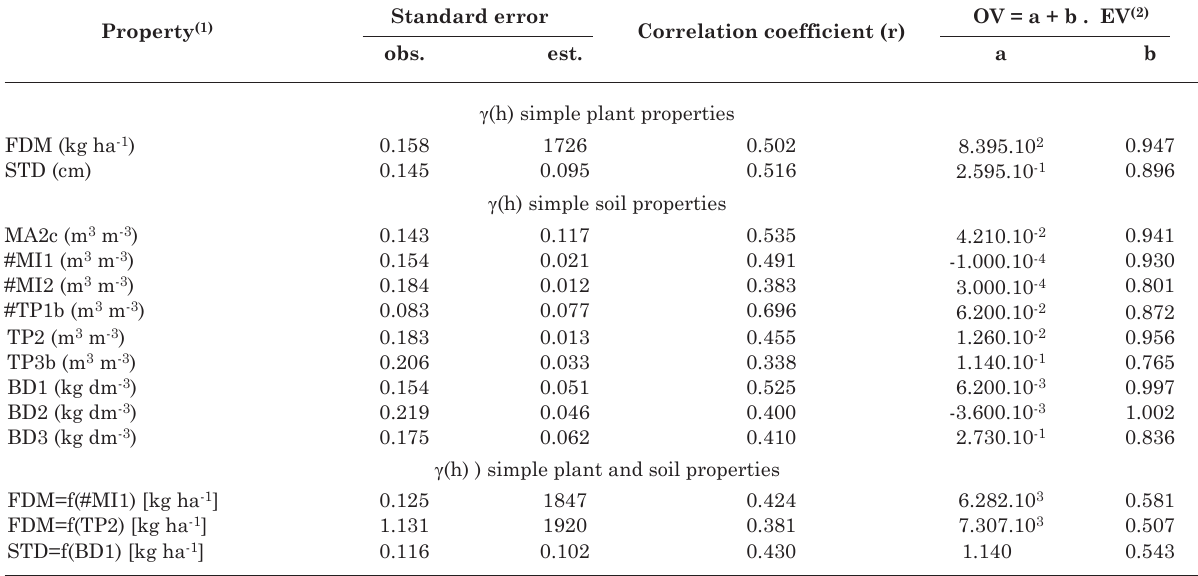
table 3. parameters of cross-validations for some properties of corn forage yield and soil physical properties of a dystrophic red